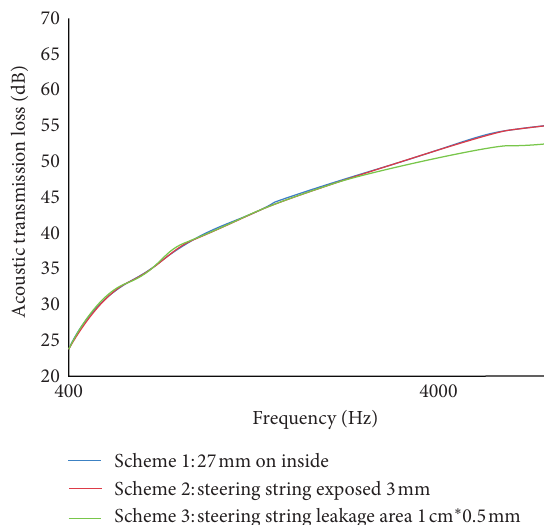
Figure 11: Compared curve of sound insulation performance of three